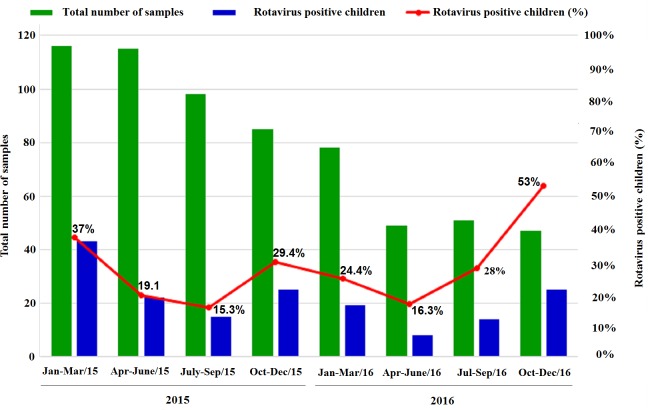
Month-wise screening of human Group A rotavirus samples among children detected with acute gastroenteritis (AGE) during 2015–2016.